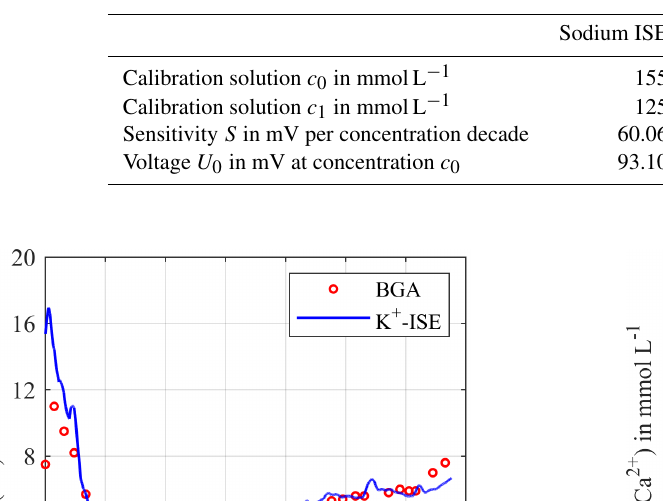
Table 1. Parameters of the ISEs obtained by the calibration.